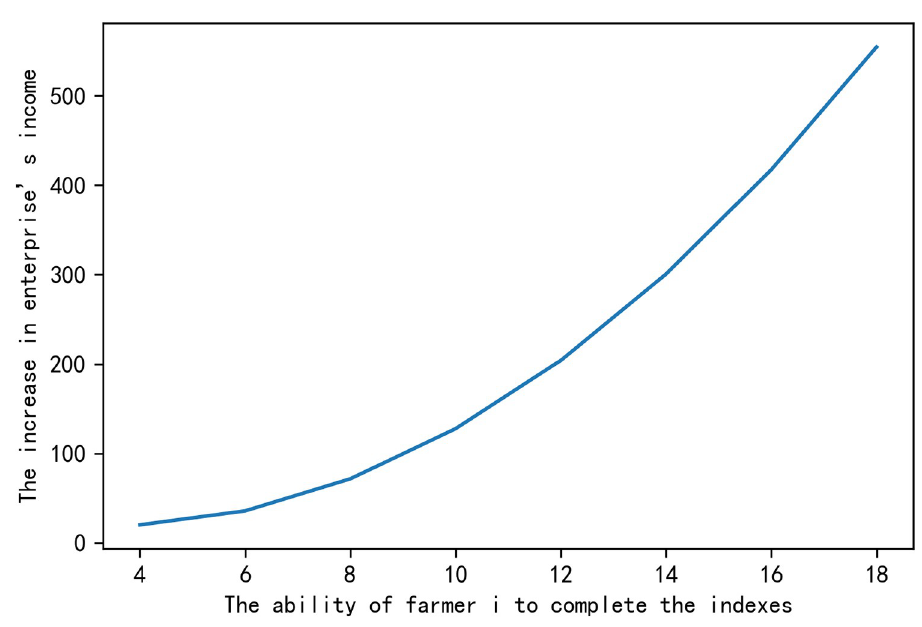
Fig 1. The impact of farmers’ ability to complete indexes on the increase in enterprise’s income.